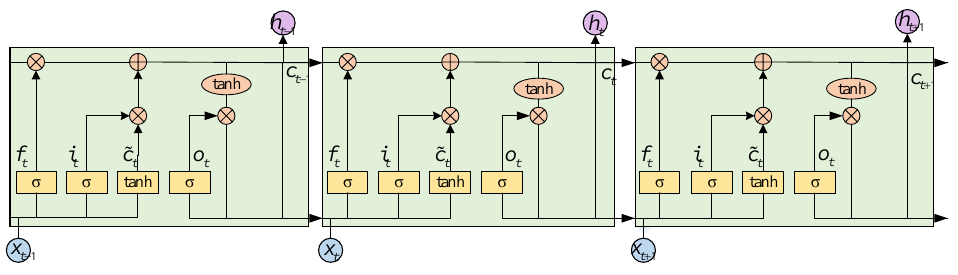
Figure 3. The basic structure of the LSTM